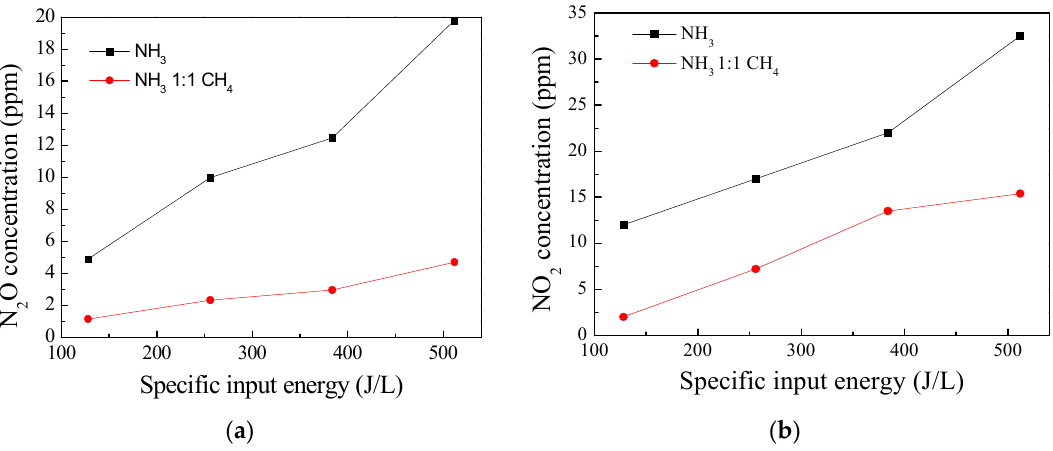
Figure 4. ( a ) N 2 O concentration for DBD–SCR at SIE ranging from 128 J/L to 512 J/L. ( b ) NO 2 concentration for DBD–SCR at SIE ranging from 128 J/L to 512 J/L. Experimental conditions: 12% O 2 , and other conditions are the same as those in Figure 2.